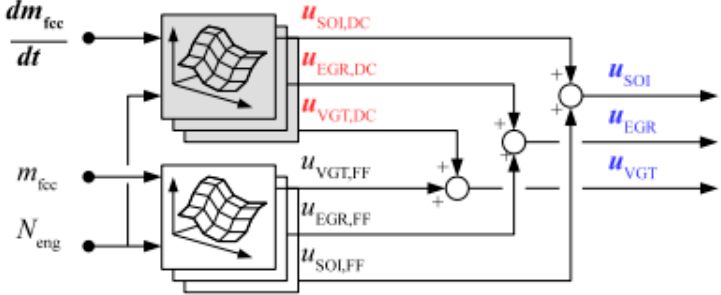
Figure 15. FF control based on the steady-state actuator set-point map.